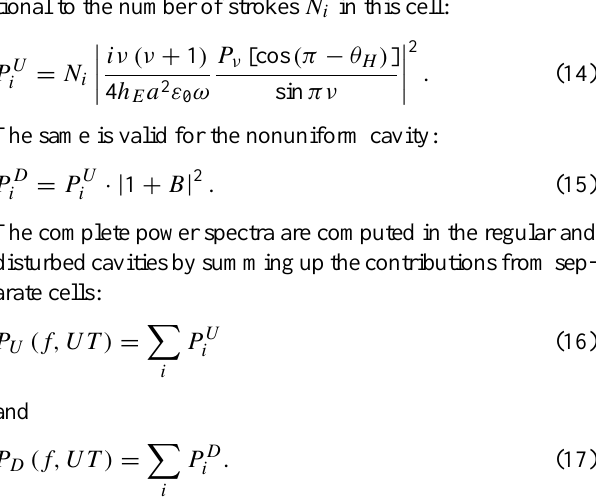
Fig. 6. Regular and disturbed fields at the Nakatsugawa observatory on particular times of the day.